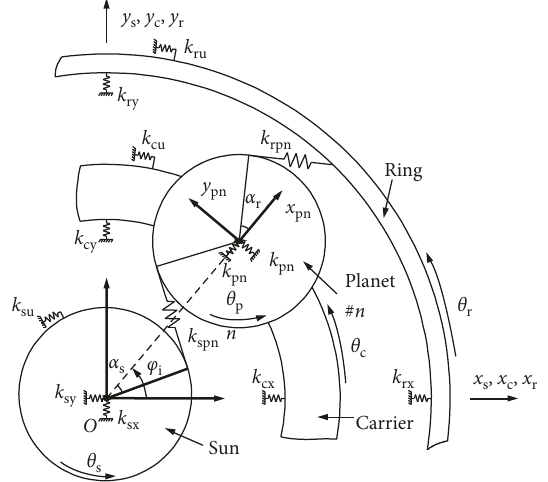
Figure 3: The dynamic model of planetary gear